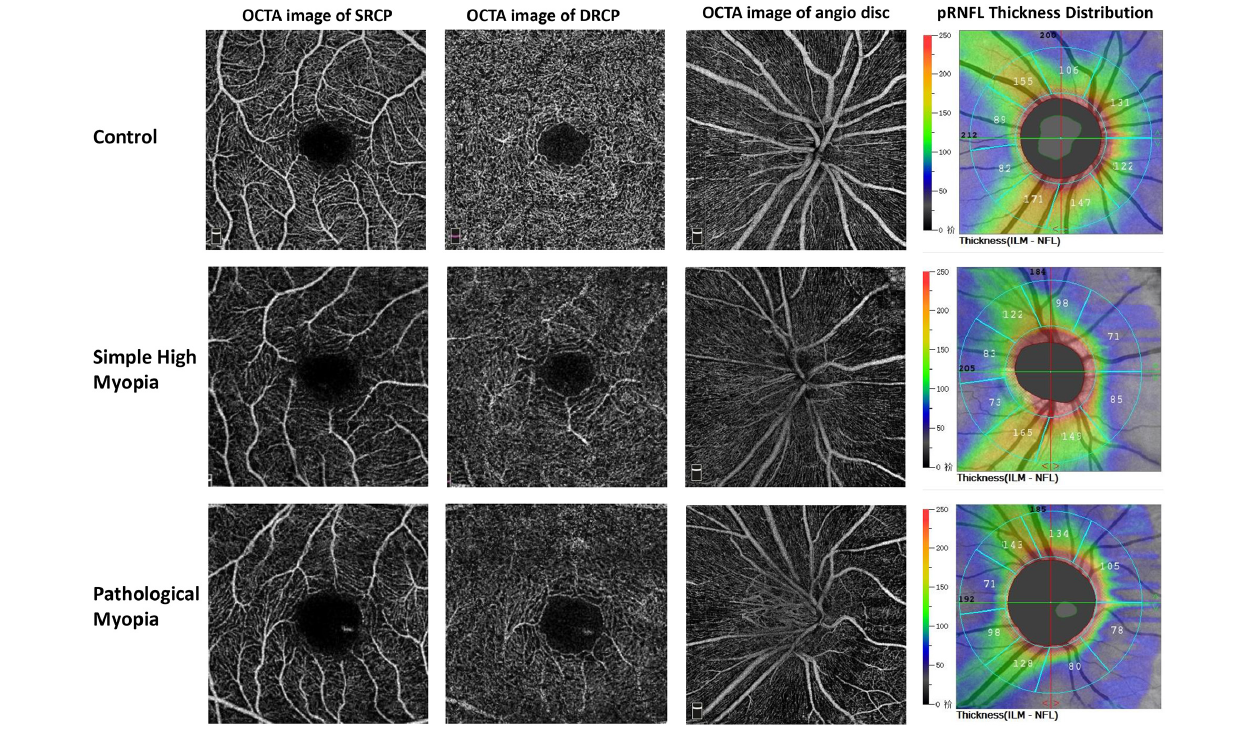
greater than 0.800, while AUCs of RPC density in other five sectors were less than 0.800 ( Figure 2B,C